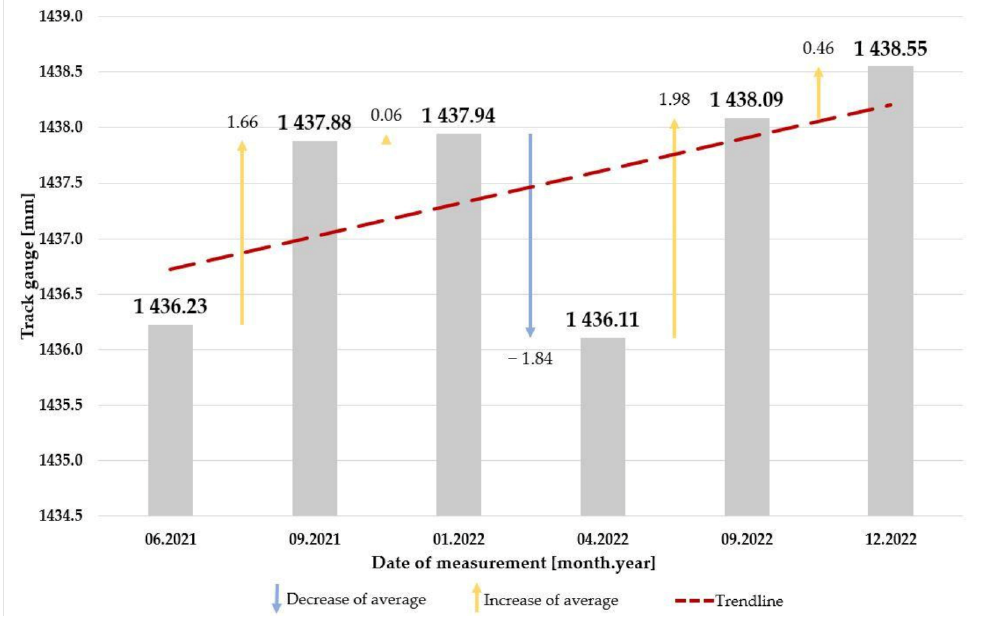
Figure 20. The change of average values of the track gauge in Section #6.